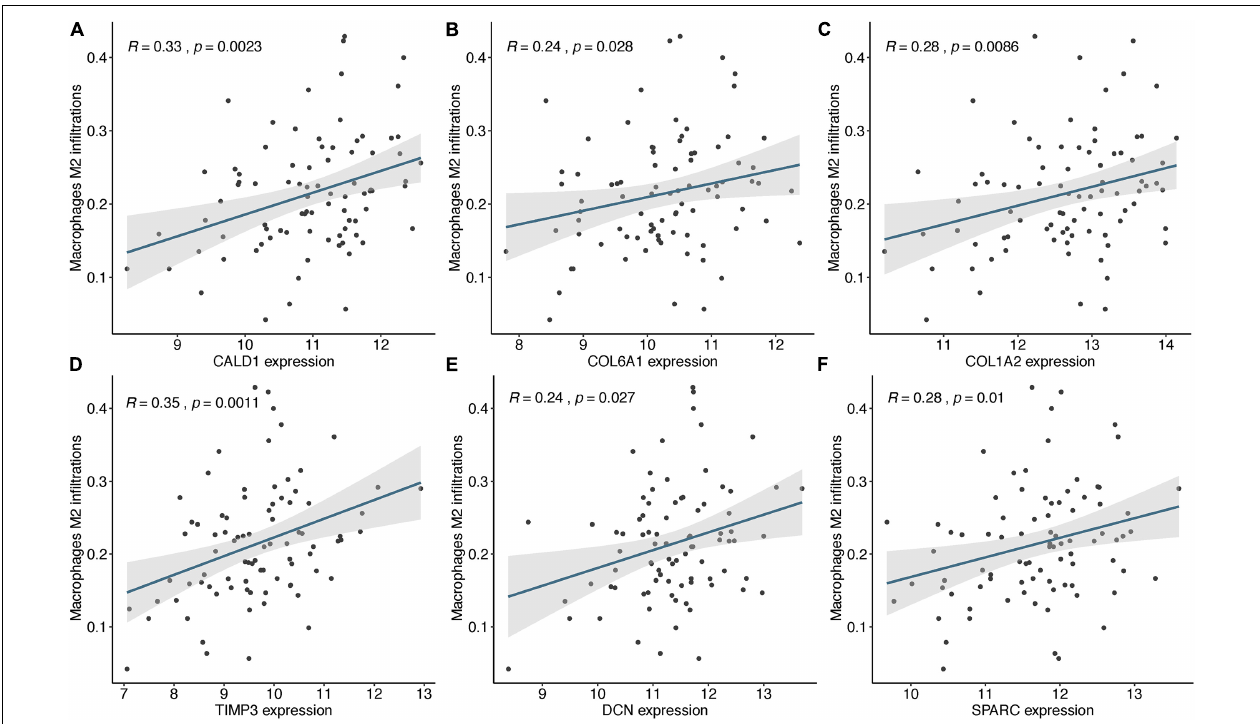
FIGURE 4 | The expressions of CALD1 (A) , COL6A1 (B) , COL1A2 (C) , TIMP3 (D) , DCN (E) , and SPARC (F) were significantly and positively correlated with M2 macrophage infiltrations.